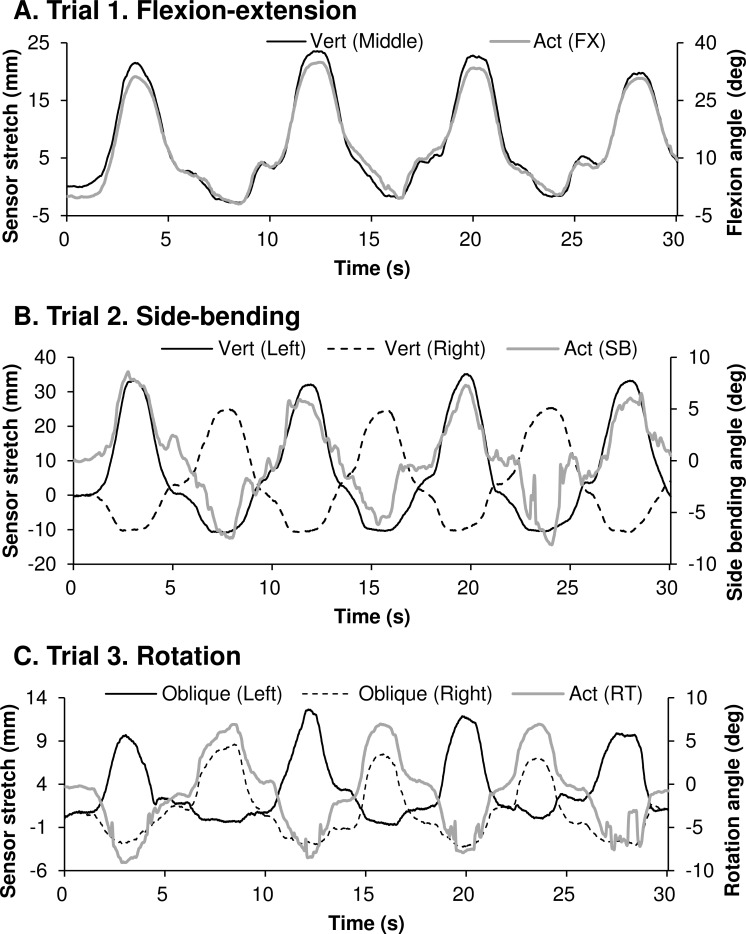
Typical time series of the angular displacement and stretch sensor outputs.Typical time series of the angular displacement of the flexion-extension (A), side-bending (B), rotation (C), and stretch sensor outputs in the three uniaxial movement trials. The gray straight lines represent the angular displacement of the lumbar joint. The black straight and dotted lines represent the stretch sensor outputs. The straight and dotted lines in panels (B) and (C) are in an anti-phase relationship with each other.